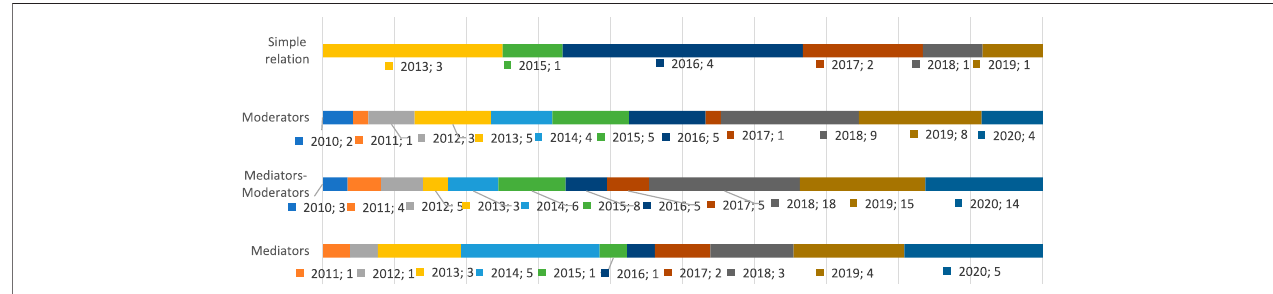
FIGURE 5 | Number of studies per year using different research designs.